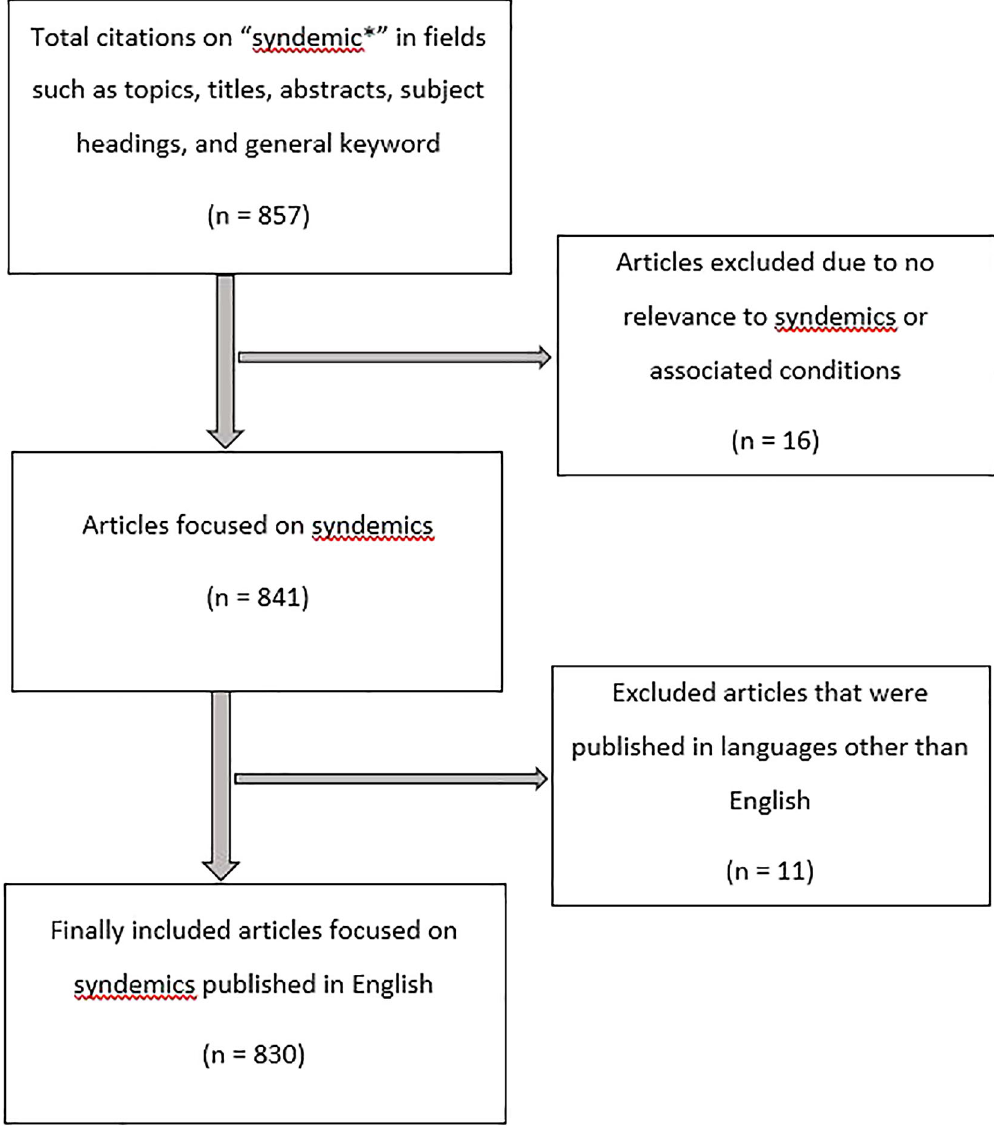
Figure 1. Citation retrival